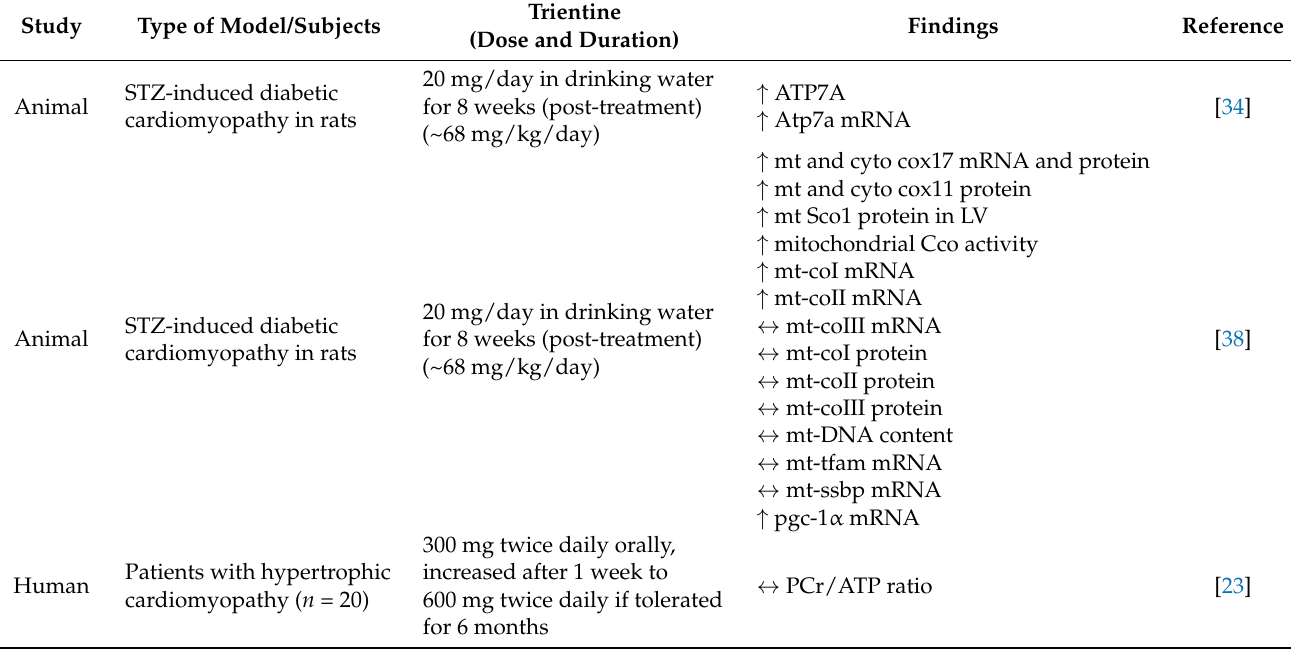
Table 2. Effects of trientine on copper chaperones involved in cardiac mitochondrial function and biogenesis in human and animal